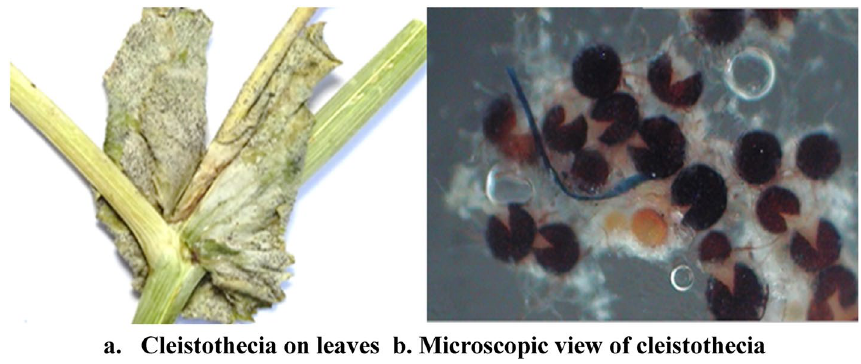
Figure 1. Cleistothecia of Erysiphe pisi causing pea powdery mildew are formed during sexual reproduction, appeared as spherical, gregarious, dark brown color, measuring about 87.5–133 µm in diameter and dispersed in the mycelial web.